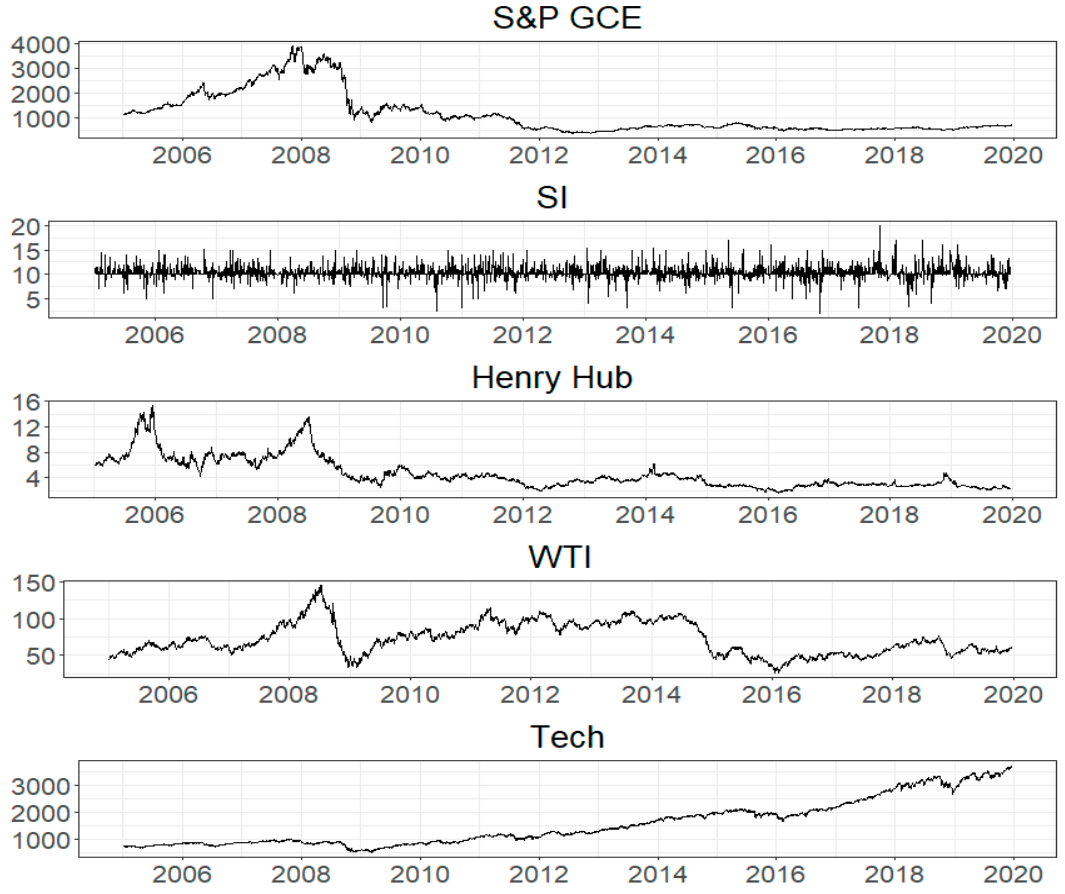
Figure 1. Time variations of variables. Note: S&P GCE, Standard & Poor Global Clean Energy Index; Henry Hub, Henry Hub Natural Gas Futures; WTI, West Texas Intermediate Crude Oil Futures; Tech, NYSE Arca Tech 100 Index; SI, investor sentiment index.